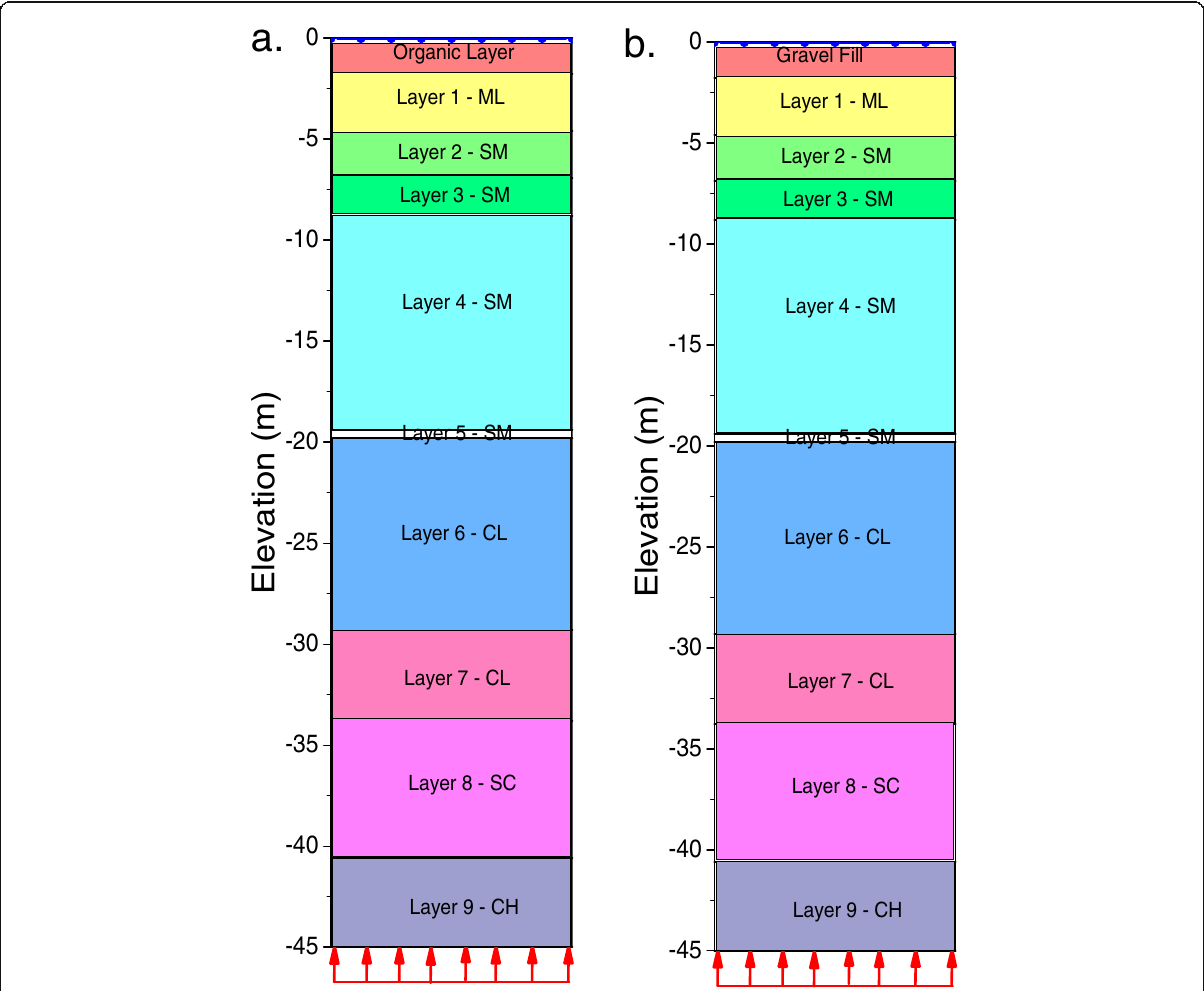
Fig. 6 Comparison of two TEMP/W models: a ) with organic layer at the surface, b ) with a gravel layer at the